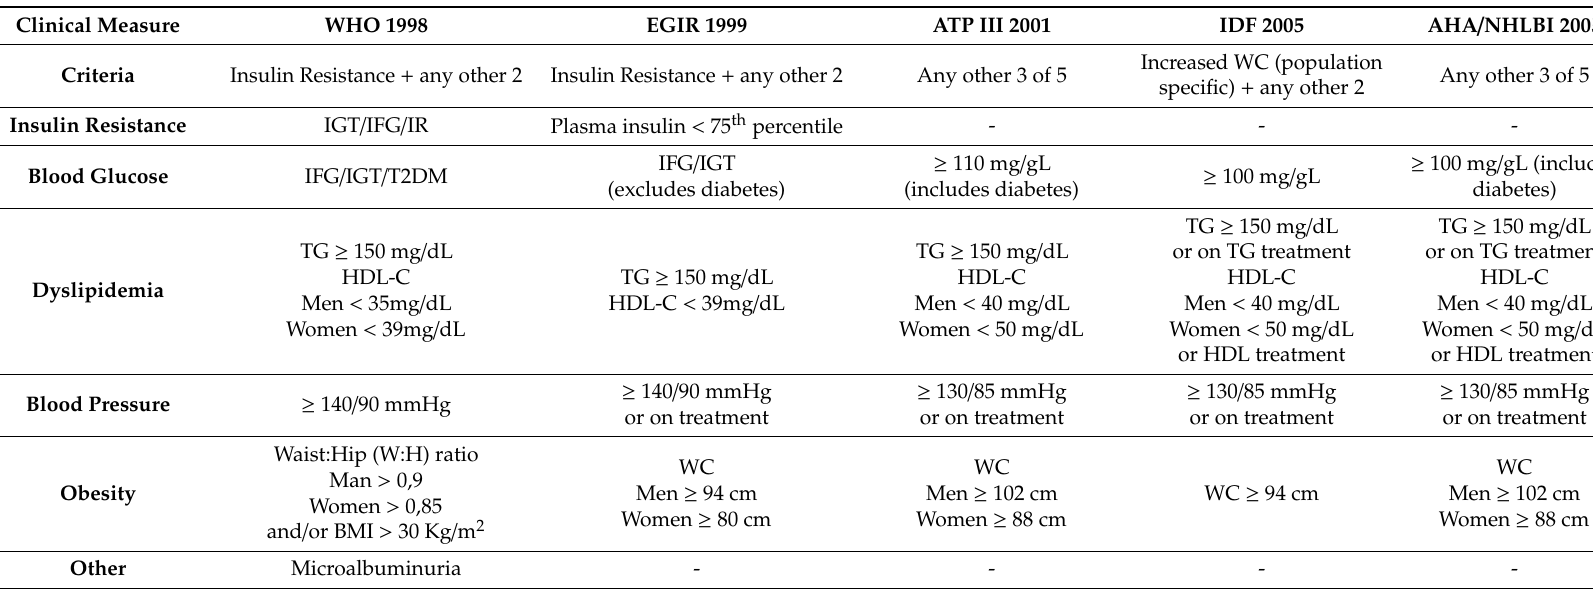
Table 1. Diagnostic criteria for metabolic